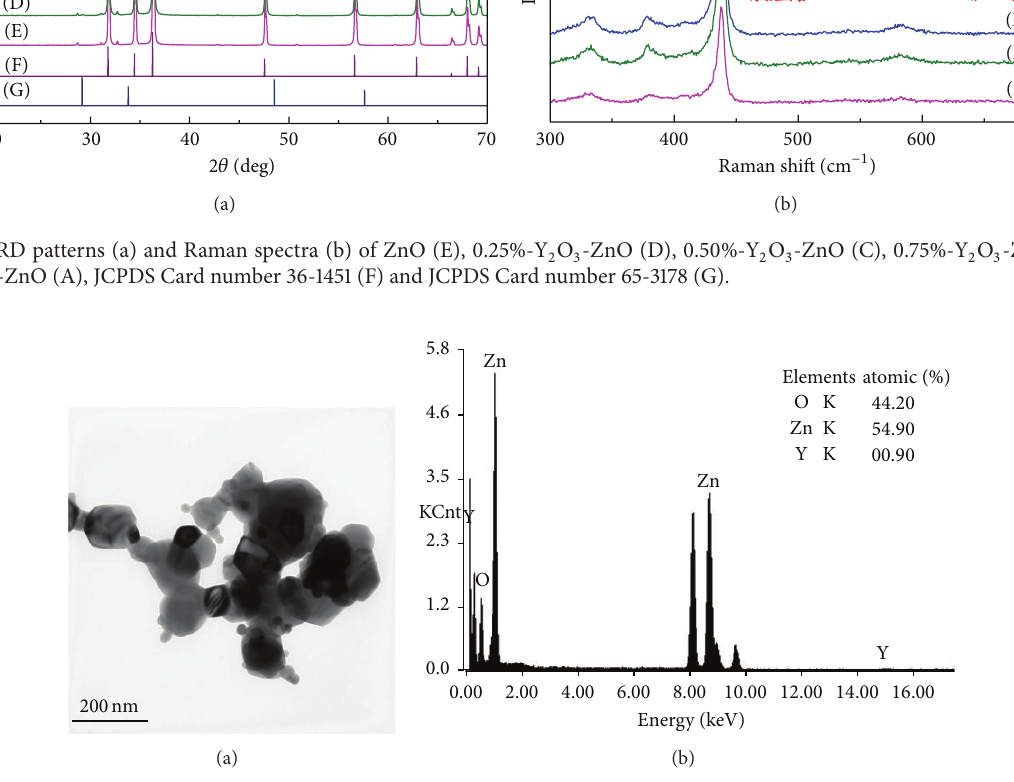
Figure 2: TEM image (a) and energy dispersive X-ray spectrum (EDS) of 0.50%-Y 2 O 3 -ZnO